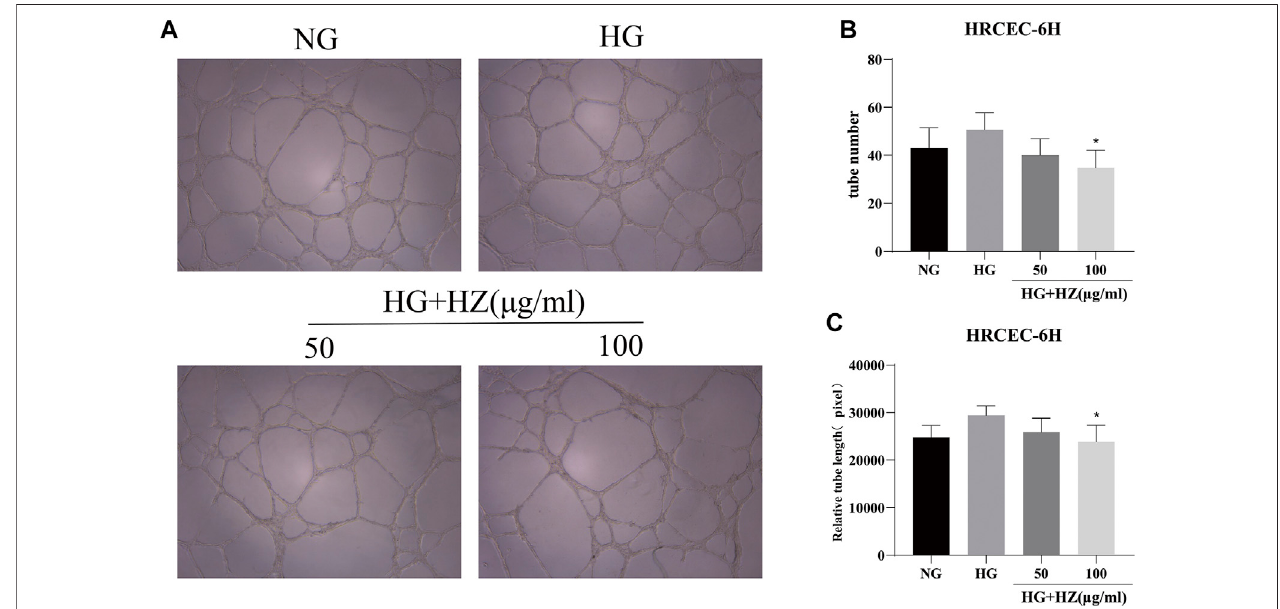
FIGURE 3 | Tube formation assay of HZQMY. (A) Tubulogenesis simulates angiogenesis in vivo . Magni fi cation, × 40. (B) The number and length (C) of tube formation were analyzed. * indicates p < 0.05 vs HG group. HZ: HZQMY.